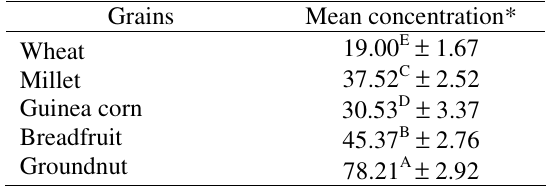
(µg kg -1 ) in food grains from markets in 1